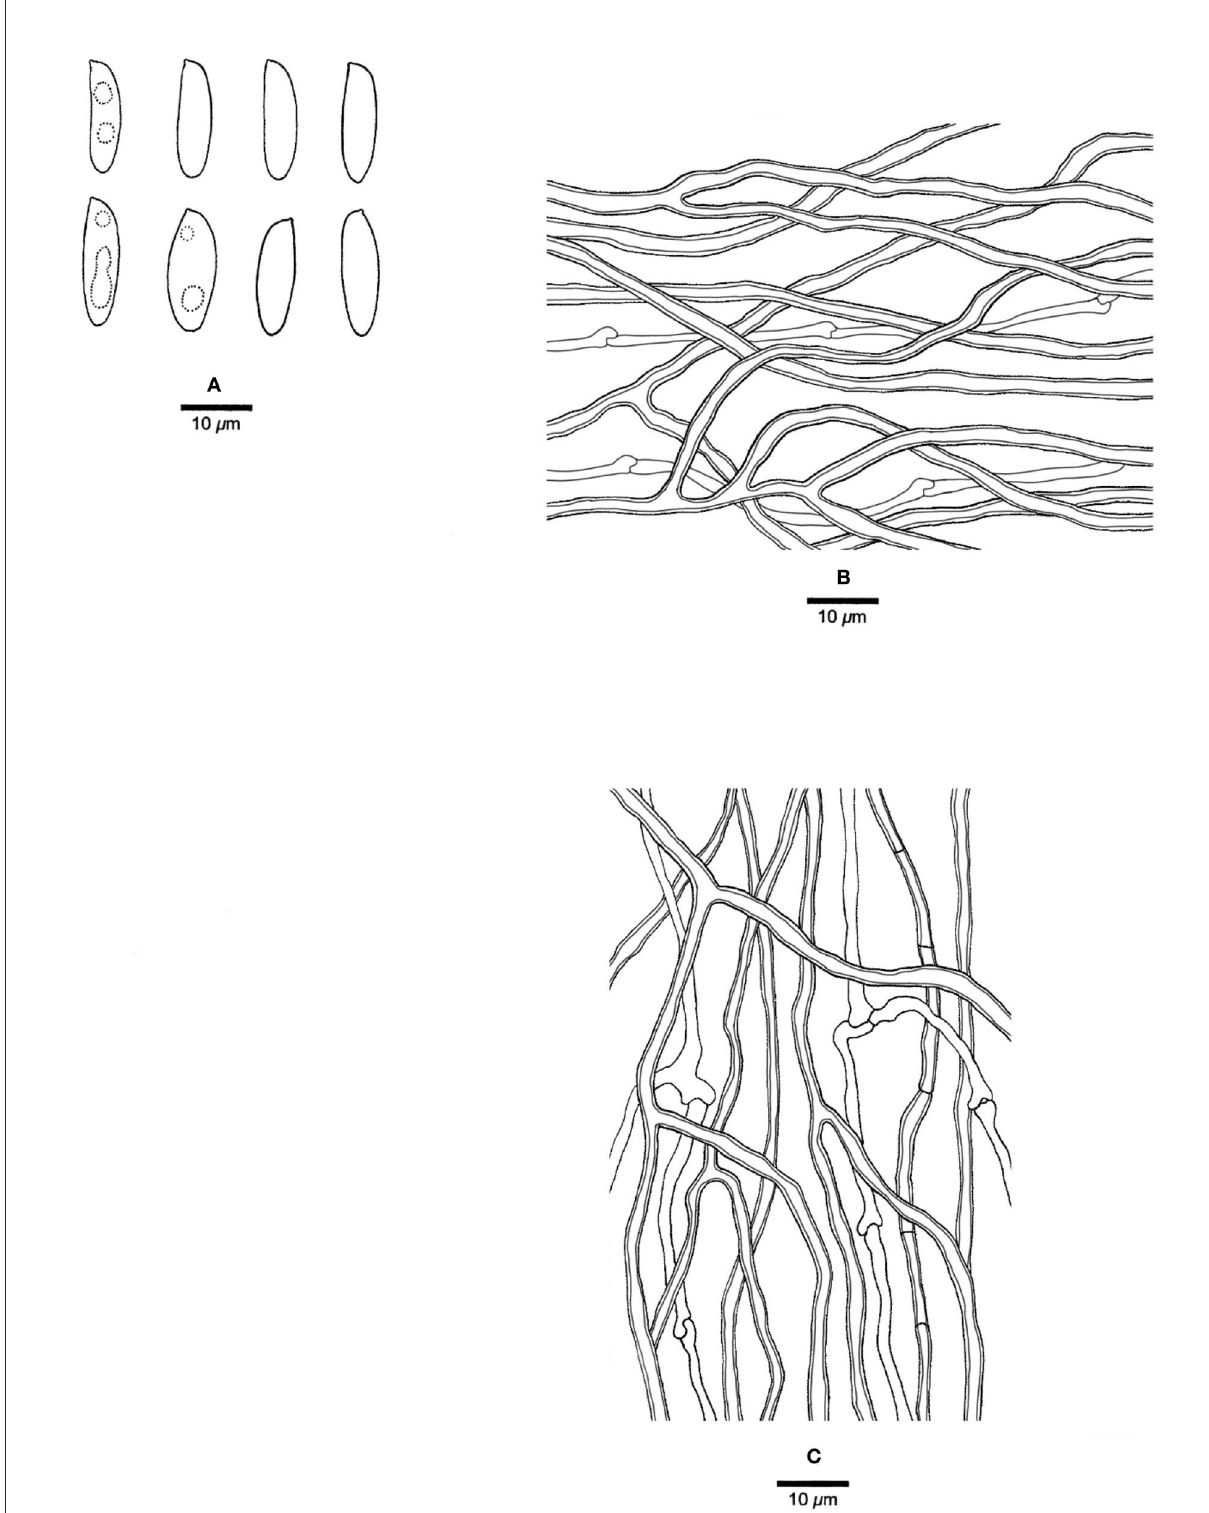
FIGURE7 Microscopic structures of Jorgewrightia tenuis (drawn from holotype, Dai 20510). (A) basidiospores, (B) hyphae from subiculum, and (C) hyphae from tube